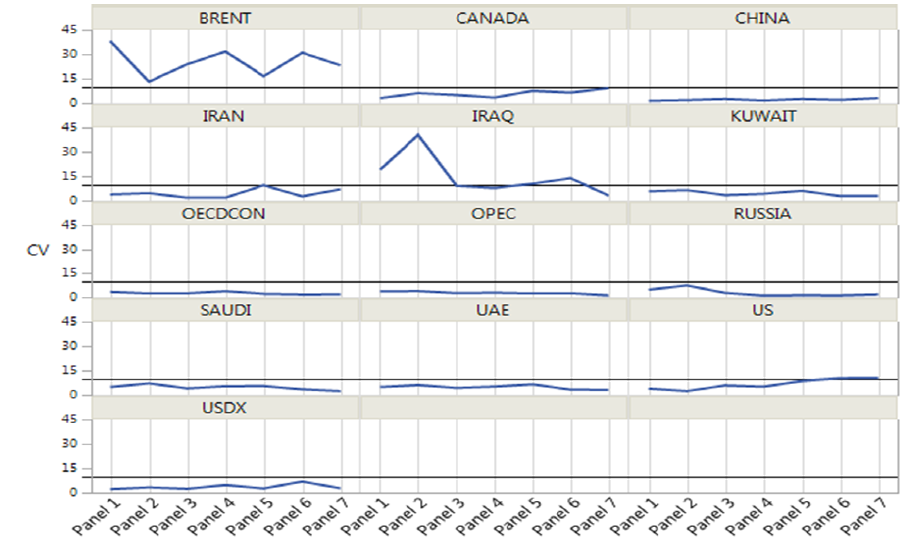
Figure 5. Coefficients of variations for each variable by panel. CV: coefficient of variable. Figure 5. Coe ffi cients of variations for each variable by panel. CV: coe ffi cient of variable.